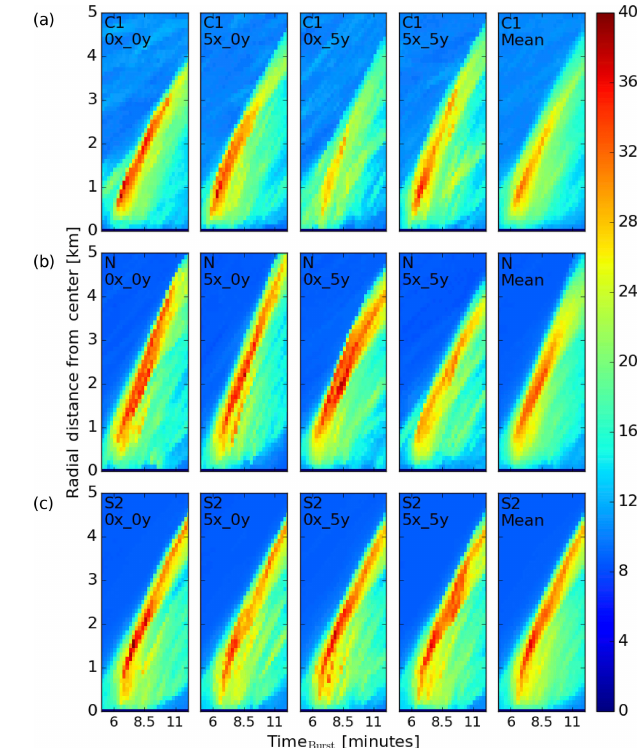
Figure 10. Variation with time of the horizontal wind speed (ms − 1 ) at the lowest model level at binned radii to the right of the downburst center for cases C1 (a) , N (b) , and S2 (c) . Each case is presented in the first four columns while the ensemble mean is shown in the right column.